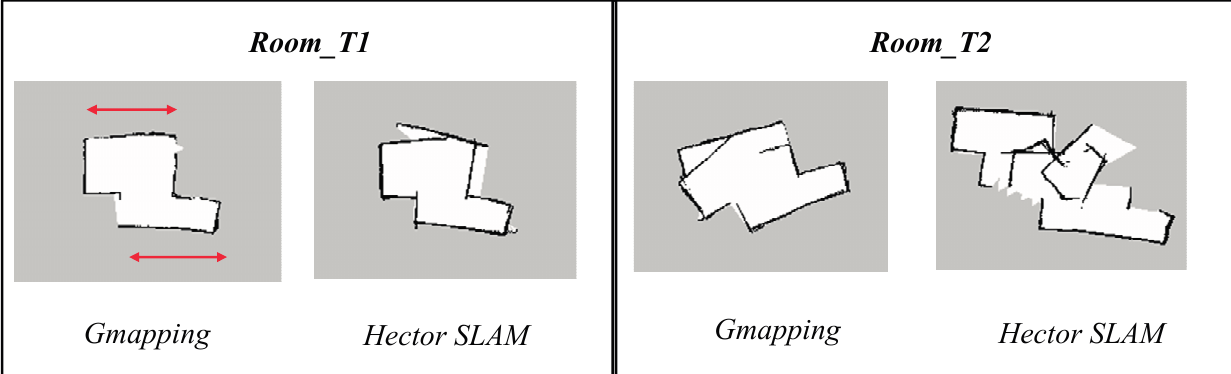
Figure 9. Comparison of Gmapping and Hector SLAM maps obtained using default